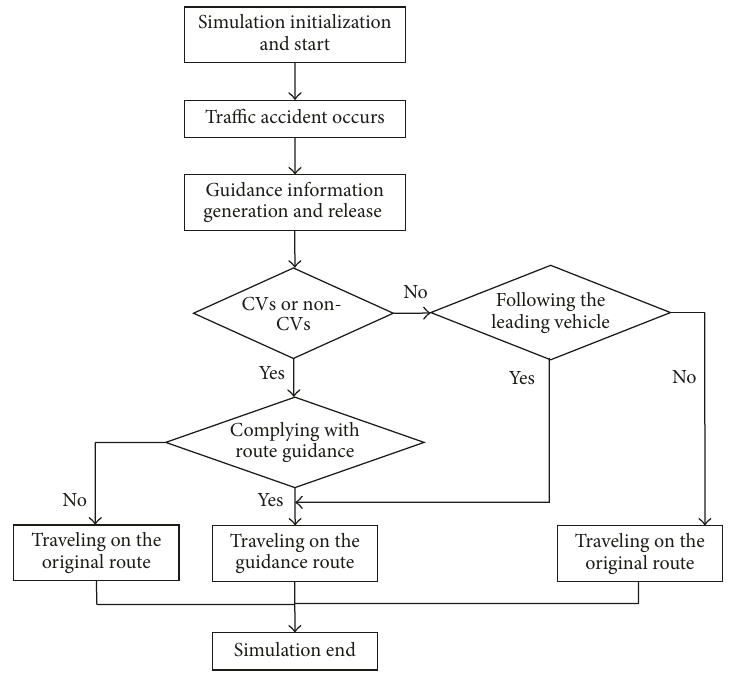
Figure 4: Flow chart of traffic guidance strategy.